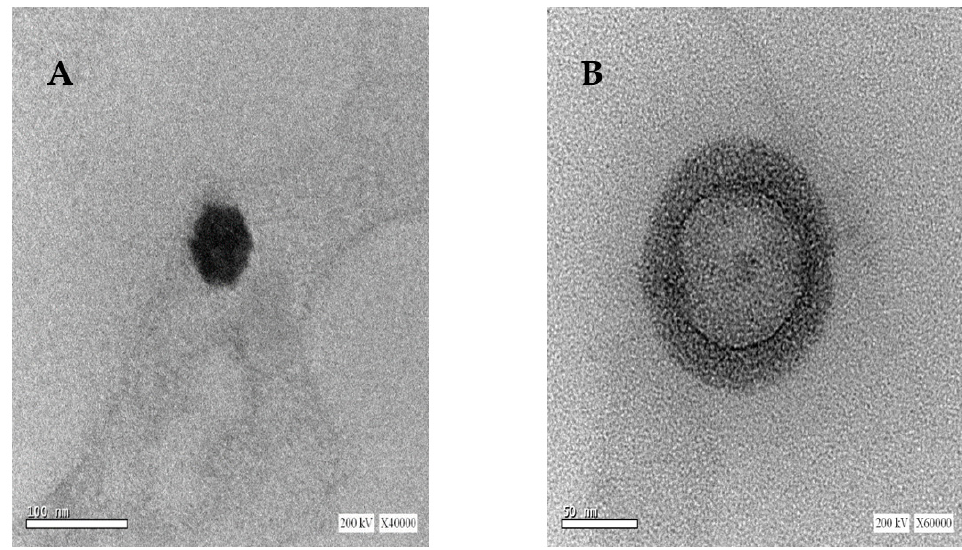
Figure 1. TEM micrographs of Poloxamer 407 based ( A ) uncoated SLNs and ( B ) CS-coated